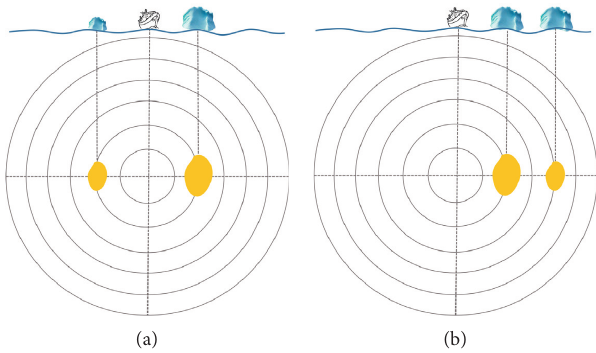
Figure 2: Ice echoes in radar images in various